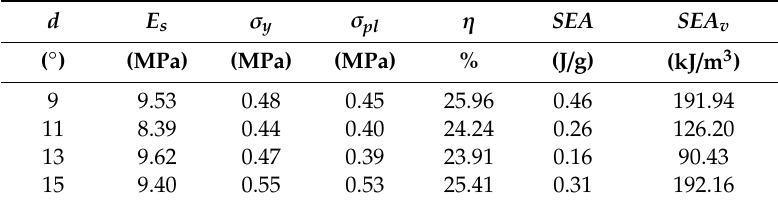
Table 3. The mechanical property of TPU model.